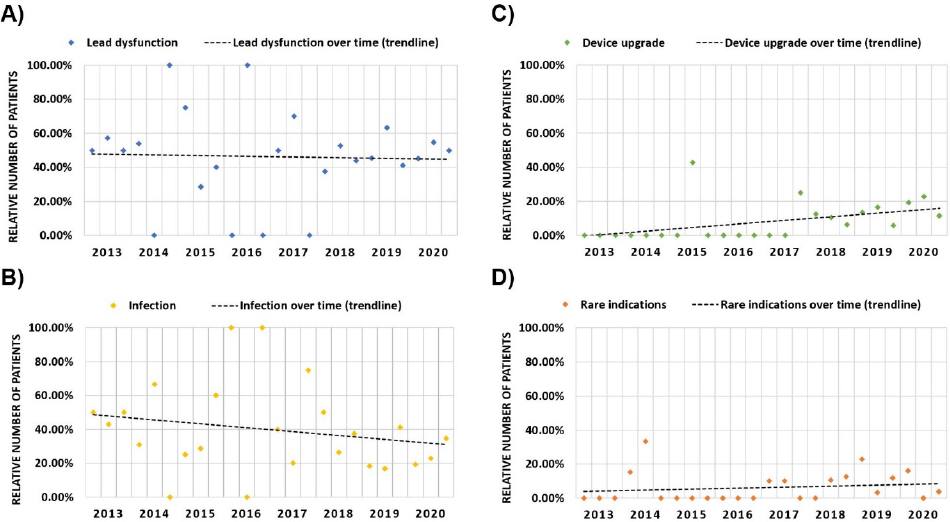
Figure 2. Indications for transvenous lead extraction. Distribution of indications for transvenous lead extraction between 2013 and 2020. The most common indications are illustrated on the left (lead dysfunction, infection, device upgrade), while rare indications are further detailed on the right.